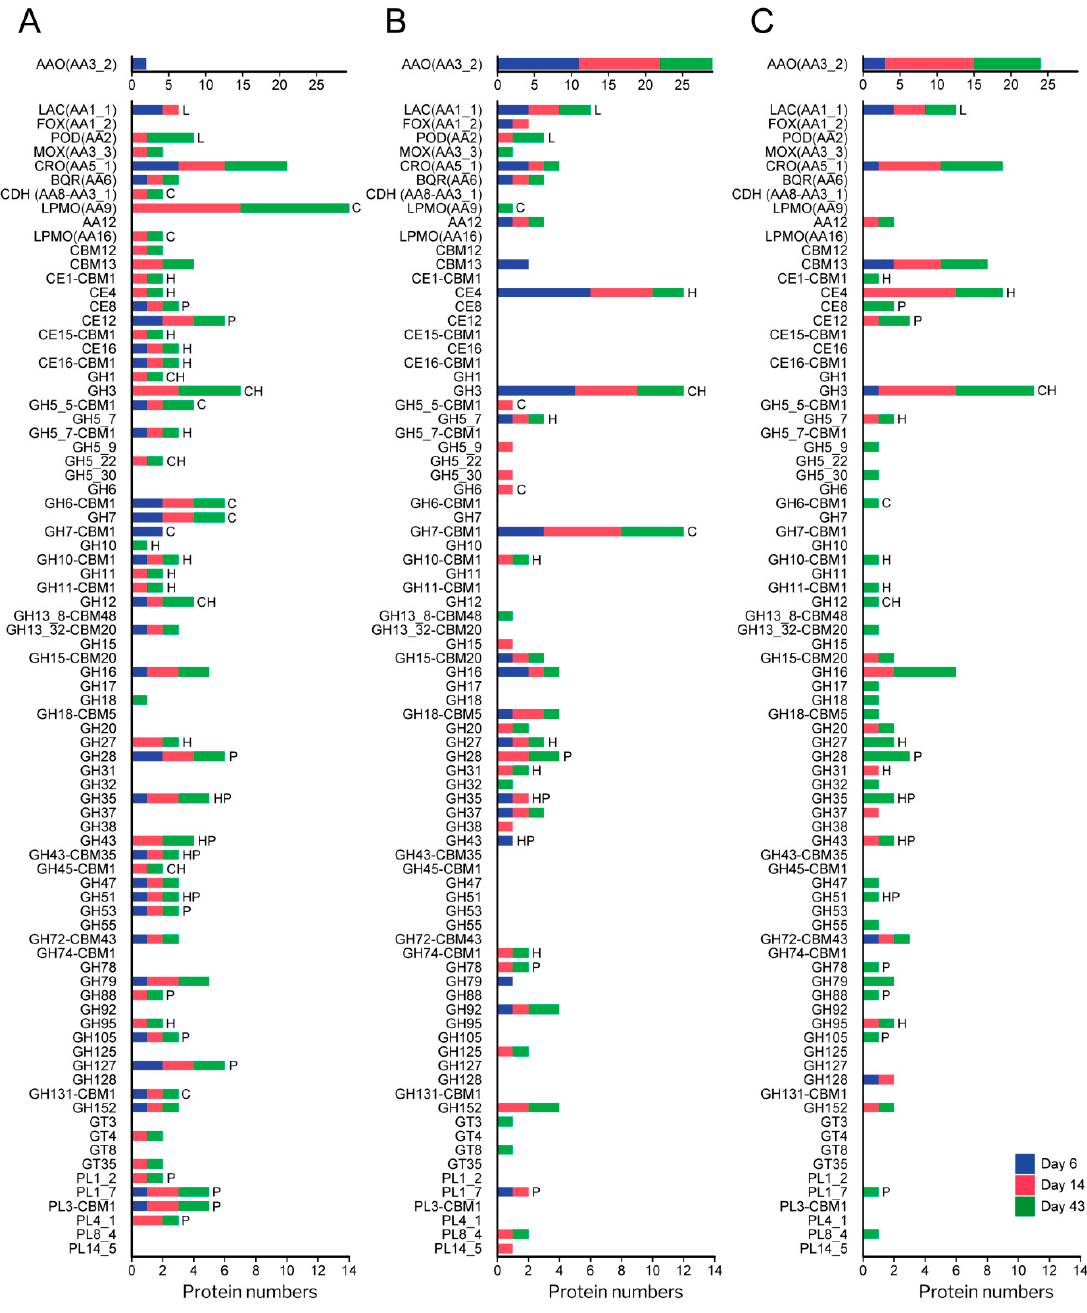
Figure 6. Diversity of CAZymes and oxidoreductases (AA) in the exoproteome of P. eryngii grown on wheat–straw and in glucose–ammonium medium. ( A ) Number of up-regulated (from Figure 7) and a few only highly transcribed (from Table S5), and ( B ) basally expressed (from Figure 8) enzymes of each (sub)family identified in the exoproteome of wheat–straw; and ( C ) number of enzymes identified in glucose–ammonium medium. The length of the bars represents the total number (sum) of proteins of each CAZyme and AA (sub)family identified on day 6 (blue section), 14 (red section) and 43 (green section). Although transcriptomic data were not available for day 43, we assumed that regulation of day 14 was maintained considering that the proportion of GHs, CEs, PLs and AAs was relatively stable (Figure 4C). The substrates on which the enzymes act are indicated: C, cellulose; H, hemicellulose; L, lignin; and P, pectin. Although laccases (Lac) and PODs are the only oxidoreductases here assigned a function (acting on lignin); AAO, methanol oxidases (MOX) and CRO (producing H 2 O 2 ); and benzoquinone reductases (BQR) can be considered to be indirectly involved in lignocellulose